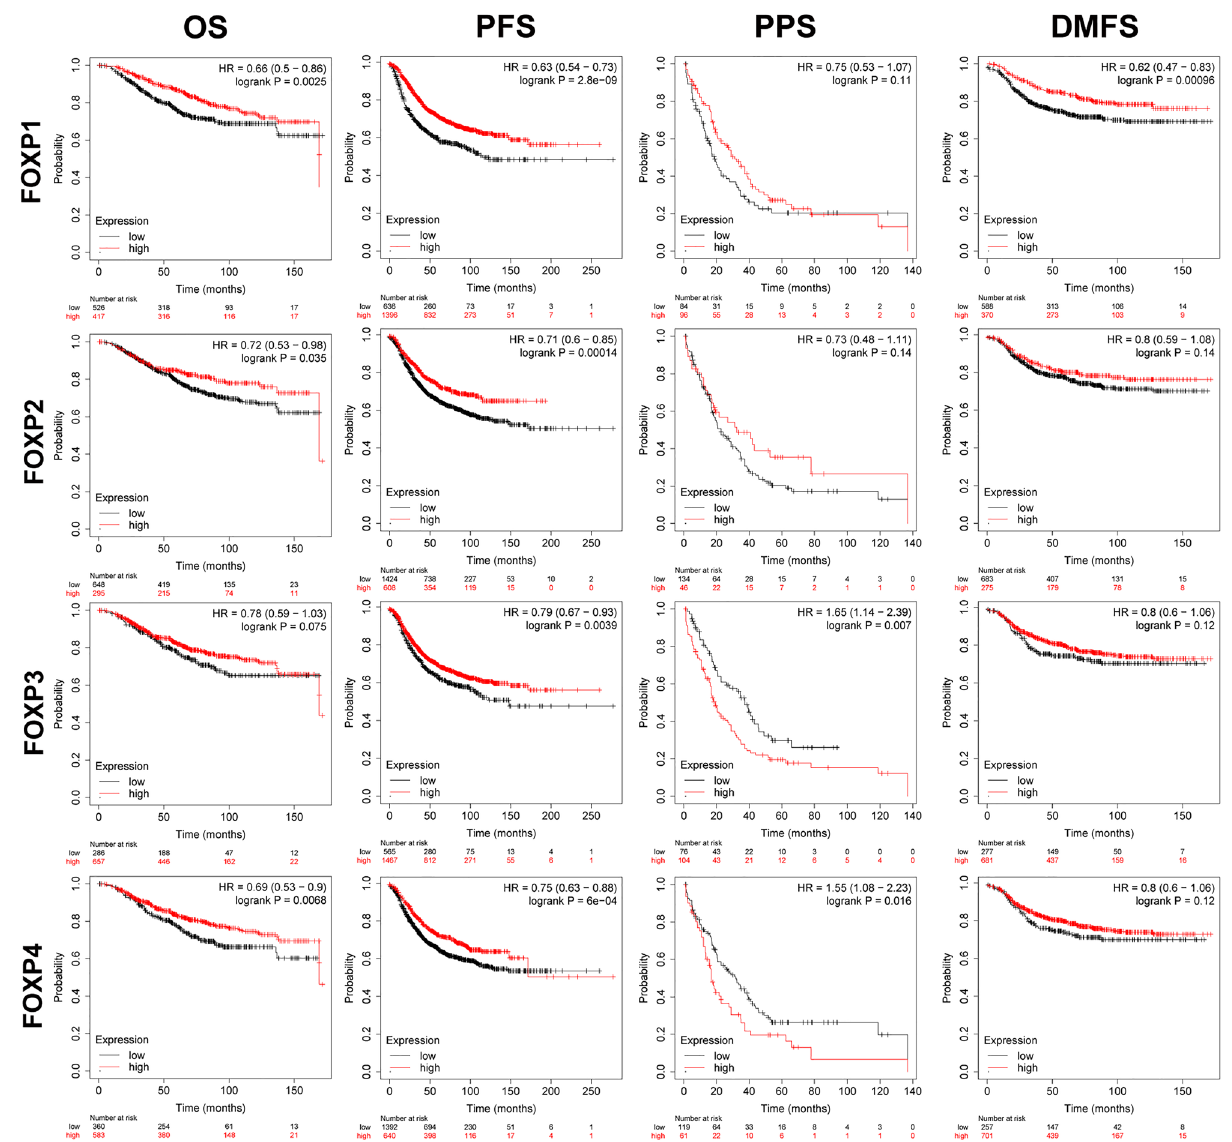
Figure 2. The prognostic value of mRNA Level of FOXPs in BRCA patients (Kaplan–Meier plotter). Overall survival (OS), progression-free survival (PFS), post-progression survival (PPS) and distant metastasis-free survival